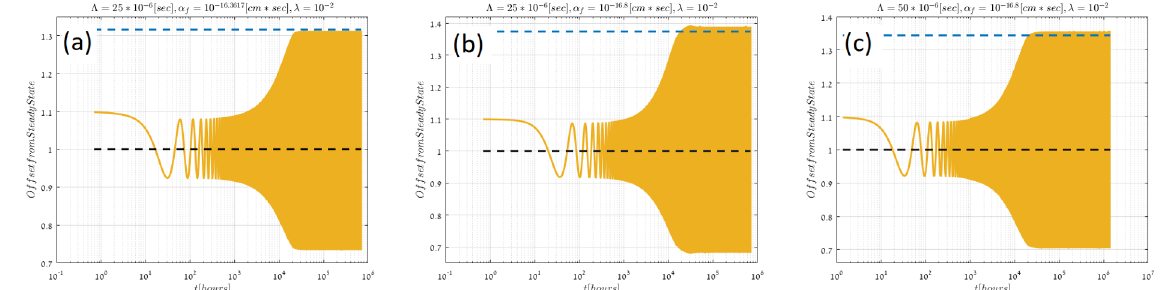
Figure 1: Temporal dynamics of the neutron flux (the offset from the steady-state flux value) for different values of power feedback and neutron generation time, for a small deviation from the neutral stability line ( λ = 10 − 2 ). The black dashed line is the steady-state solution of the flux, while the blue dashed line corresponds to the analytically-solved asymptotic amplitude of the limit cycle.